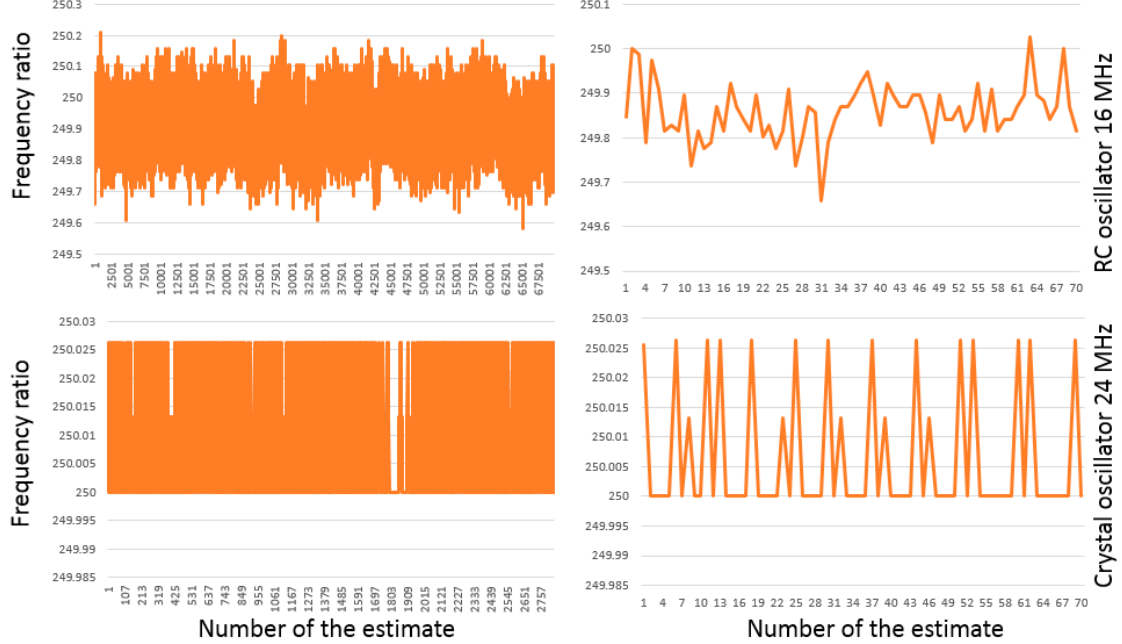
Figure 5. Measured ratios Fr / Fx for 40 periods of Fx (100 ms delay between measurements).